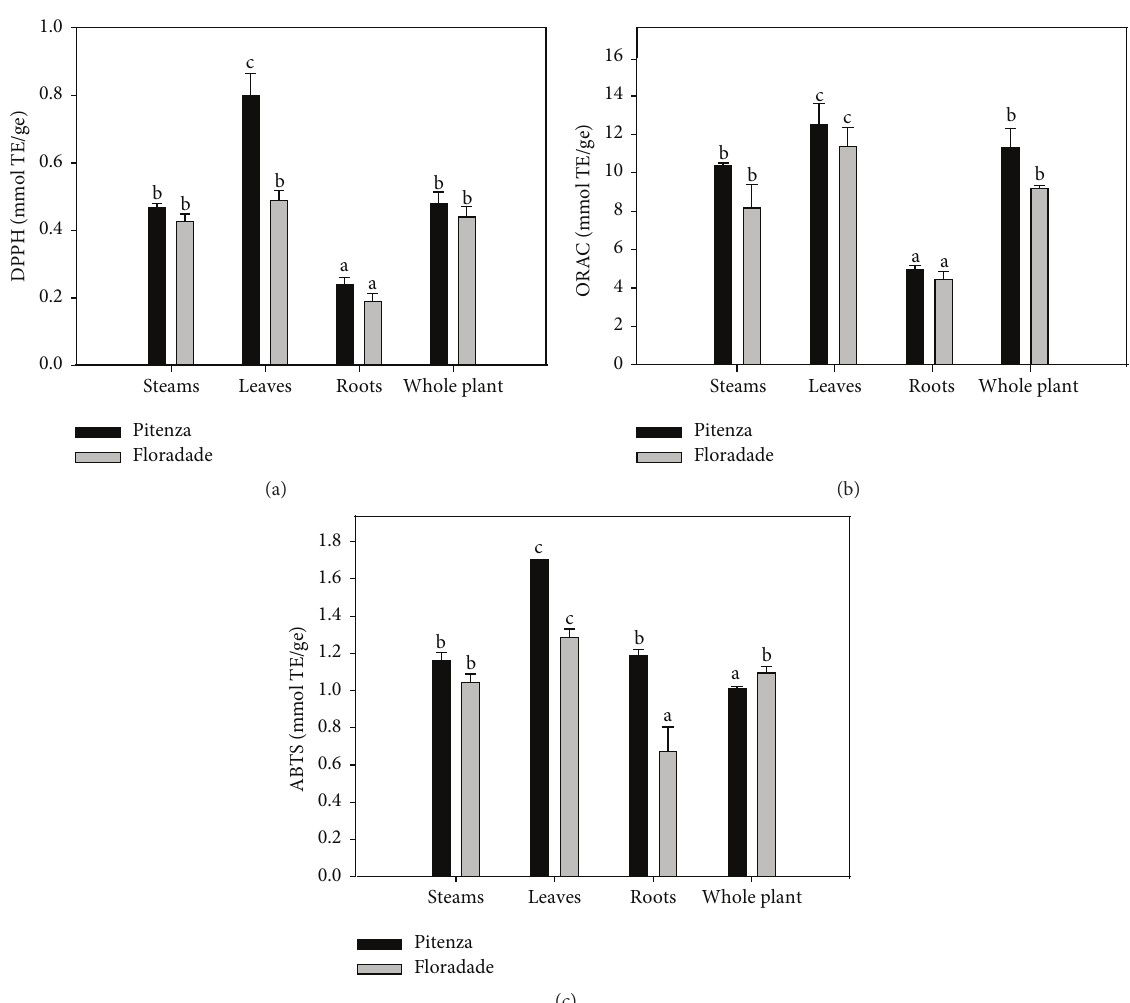
Figure 2: Antioxidant capacity measured by DPPH (a), ORAC (b), and ABTS (c) assay. Data are means of at least three determinations. Mean values in each bar followed by different letter each extracts of tomato